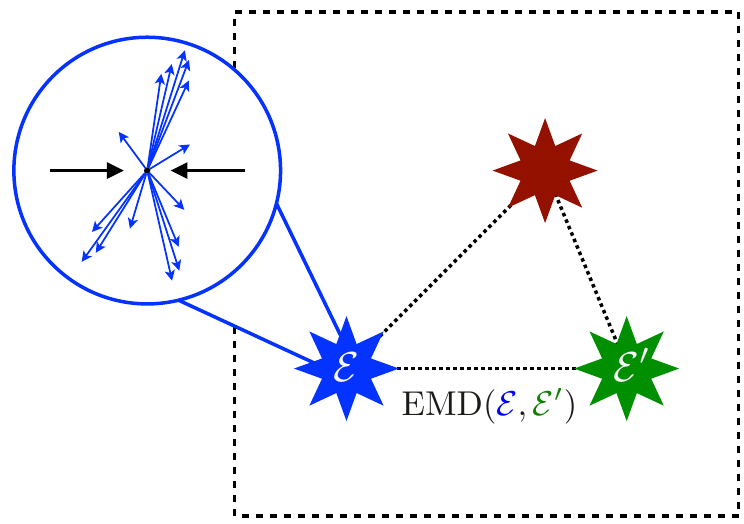
Figure 1 . An illustration of the space of events. Each point in the space is a collider event consisting of the particles produced in a collision, as indicated by the blue event. The distance between events is quanti(cid:12)ed by the EMD, giving rise to a metric space. Geometry in this abstract space of